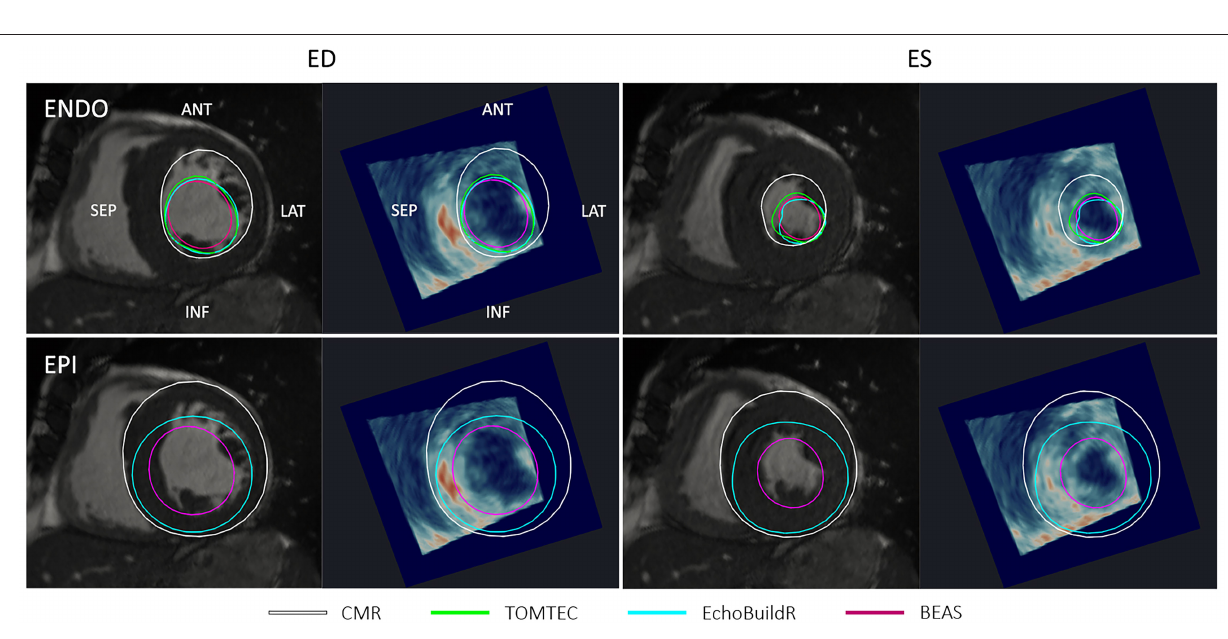
FIGURE 6 | Short-axis CMR slice and corresponding resliced 3D-echo image at end-diastole (ED) and end-systole (ES) for a patient with hypertrophied myocardium. Top row shows endocardial (ENDO) contours, and bottom row shows epicardial (EPI) contours derived using each method indicated in the legend. ANT, anterior; LAT, lateral; SEP, septal; INF,